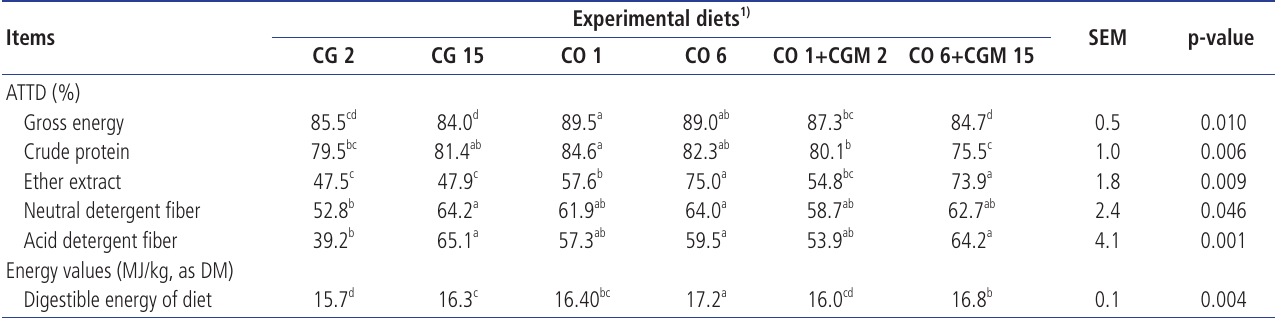
Table 5. Effect of corn lipid form on the apparent total tract digestibility of nutrients and the digestible energy (MJ/kg) of diets fed to growing pigs